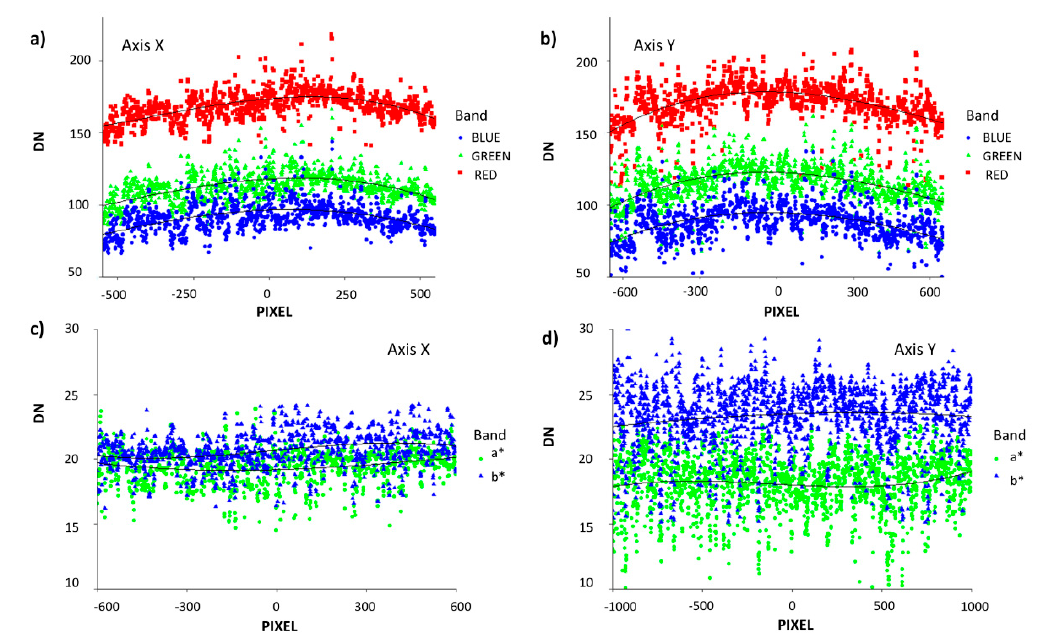
Figure 6. Vignetting effects observed in the RGB and CIELab color spaces from one example photo taken with Lumix GX7 from the UAV at 50 m, comparing x-axis and y-axis transect pixel digital number (DN) values. Hue-based color filters were used to identify only bare soil pixels along each transect. RGB channels ( a , b ). CIELab color space without lightness ( c , d ).